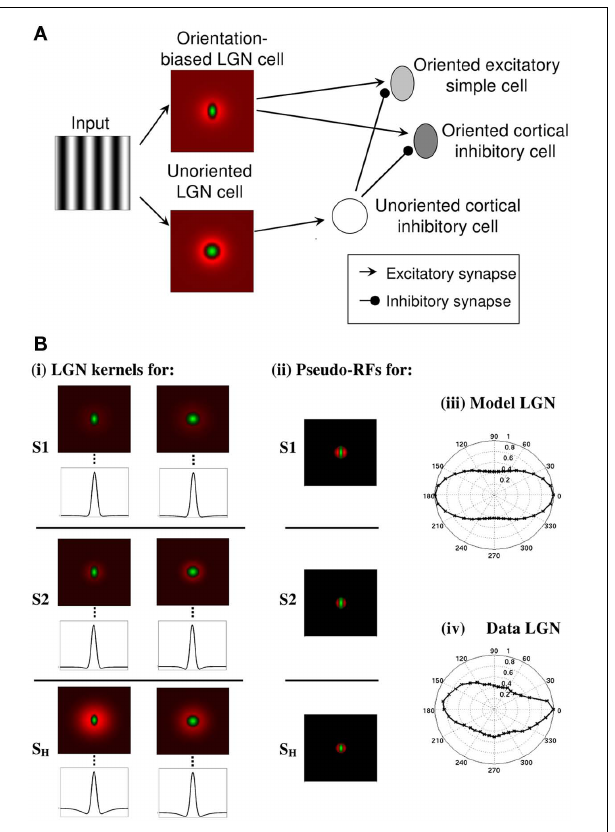
FIGURE 1 | (A) Schematic of the feed-forward component of the ALD-RM model.The input projects to ON-center LGN cells. A weakly anisotropic ON LGN field provides feed-forward excitation to the excitatory simple cell while an isotropic ON LGN field provides disynaptic feed-forward inhibition of the excitatory simple cell via an isotropic inhibitory cell. Inhibitory simple cells also receive LGN inputs in the same manner. Anisotropic LGN and simple cells are modeled for the full range of orientation preferences. As defined in the methods, oriented excitatory and inhibitory simple cells are recurrently connected across orientation following a “Mexican hat” weighting profile. (B) LGN RFs, cortical pseudo-RFs and LGN outputs. (i) The six types of DOG spatial filters which determine the LGN inputs to the simulated simple cells. Each filter is plotted in two-dimensions and as a one-dimensional plot through the vertical midline of the filter (indicated by the dashed line). For simple cell (S1): anisotropic center with a weak surround (top left) and unoriented center with a stronger surround (top right). For simple cell (S2): anisotropic center with a weak, narrow surround (middle left) and unoriented center with a stronger, narrow surround (middle right). For the simple-like hypercomplex cell (S H ): anisotropic center with a strong surround (bottom left) and isotropic center with a weaker surround (bottom right). (ii) Pseudo-RFs of the cortical cell inputs constructed by rectifying their corresponding LGN DOG kernels [shown in (i) ] and linearly combining them with the weights given in Table 1 .The top, middle and bottom rows correspond to the pseudo-RFs of the (S1), (S2), and (S H ) cells, respectively. Normalized polar bar-response plots from (iii) a simulated orientation-biased ON-center LGN cell with a weak surround and (iv) a real ON-center LGN cell recorded from a cat (Data adapted from Vidyasagar and Urbas, 1982).